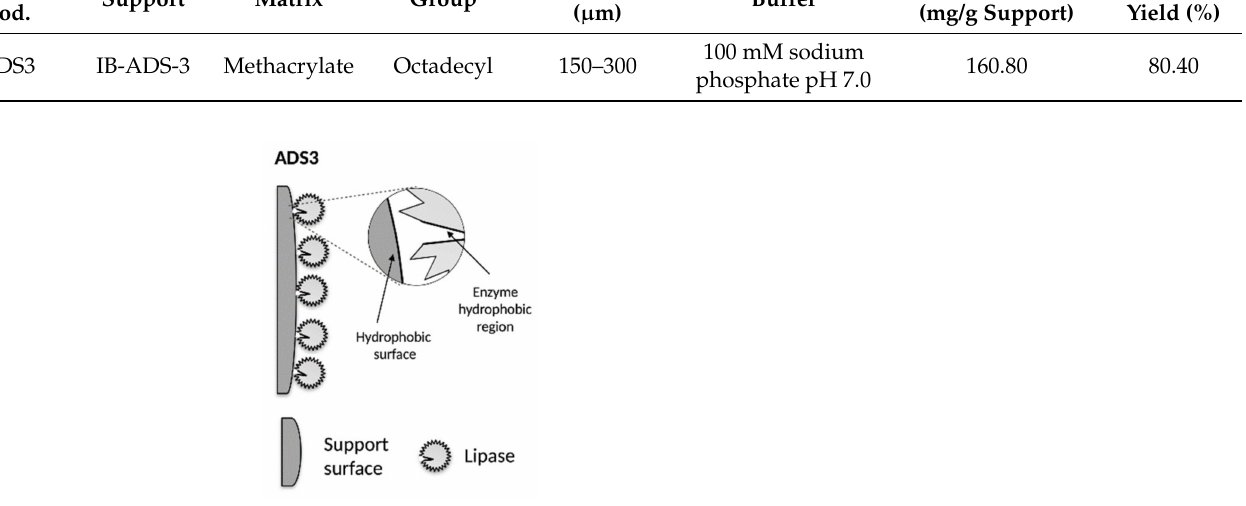
Figure 1. Schematic representation of Eversa®Transform 2.0 lipase (ET2)